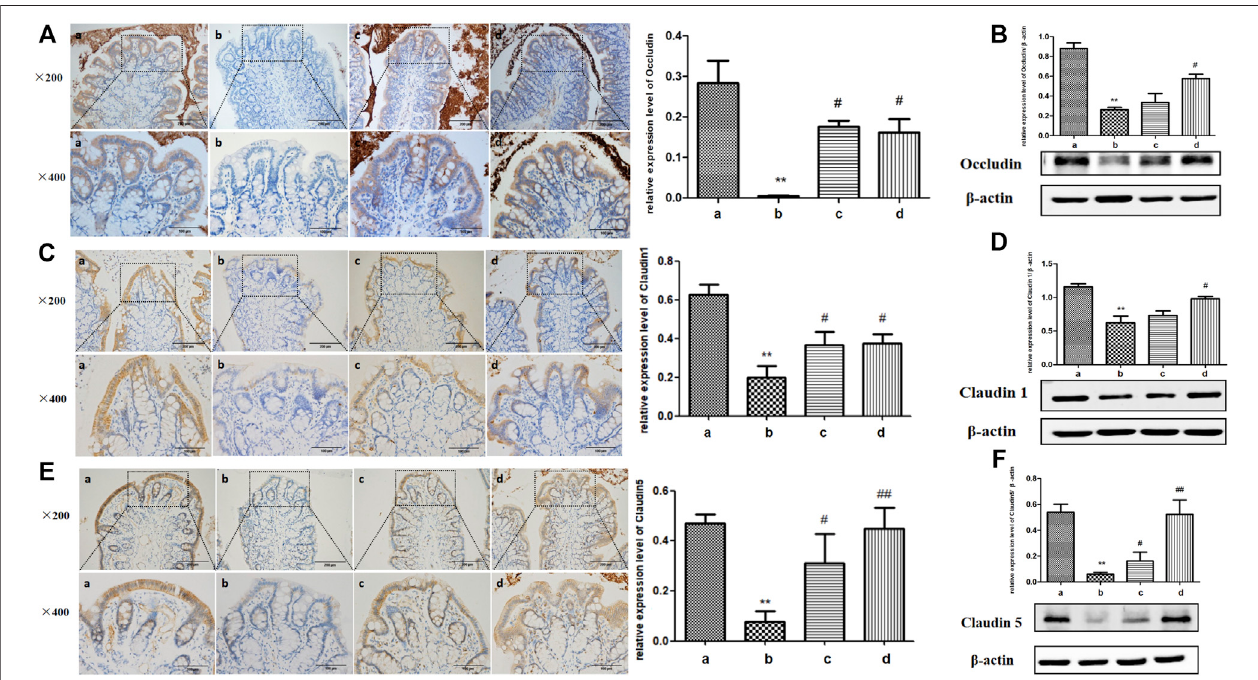
FIGURE3| EffectsofICAontightjunctionproteinsofcolonicepitheliuminagingrats.Expressionsof (A,B) Occludin, (C,D) Claudin-1,and (E,F) Claudin5between colonic epithelial cells in aging rats were detected by IHC and Western blot (×200, ×400). a: Adult group, b: Aging group, c: ICA-L group, d: ICA-H group. ** p < 0.01 vs.